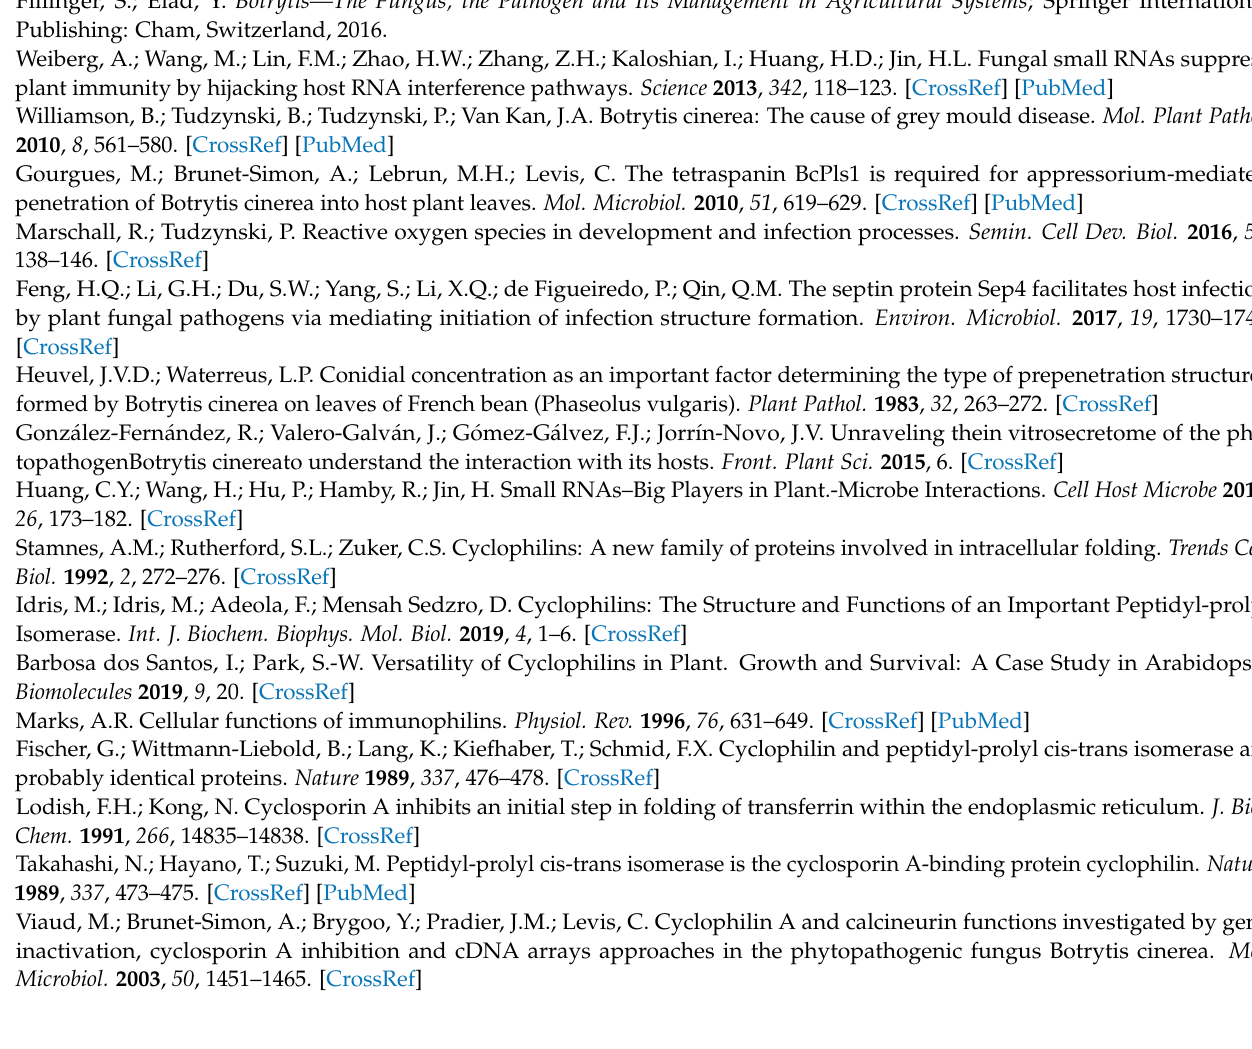
cinerea impairs virulence of the pathogen. Figure S7: Dimethyl sulfoxide (DMSO) does not affect B. cinerea growth at the concentration that dissolved CsA. Figure S8: BcCyp2 regulates expression of calcineurin-dependent (CND) genes. Table S1: Subcellular localization and domains of putative cyclophilins in B. cinerea . Table S2: Primers used in this